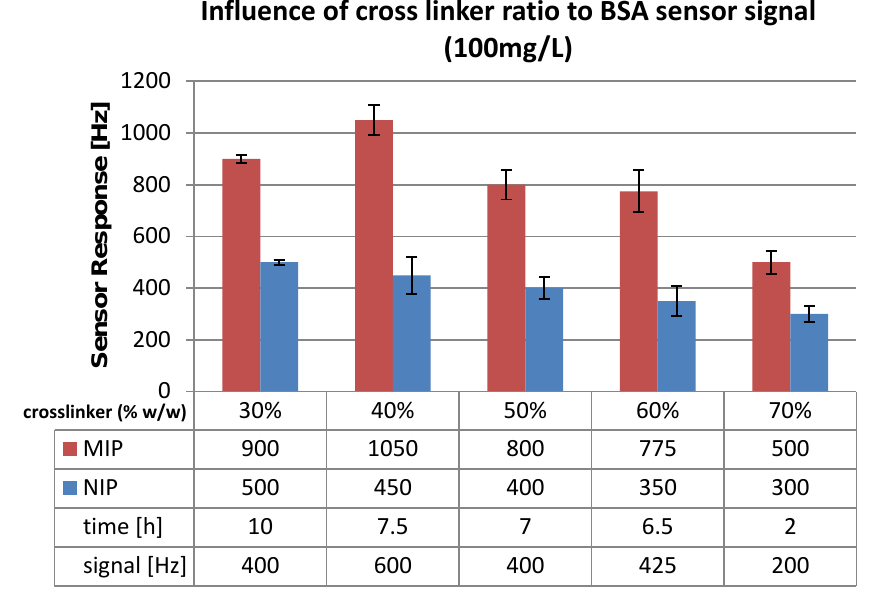
Figure 4. Sensor signals for MIP containing different amounts of cross linker (w/w); functional monomers (MAA:VP; 5:2